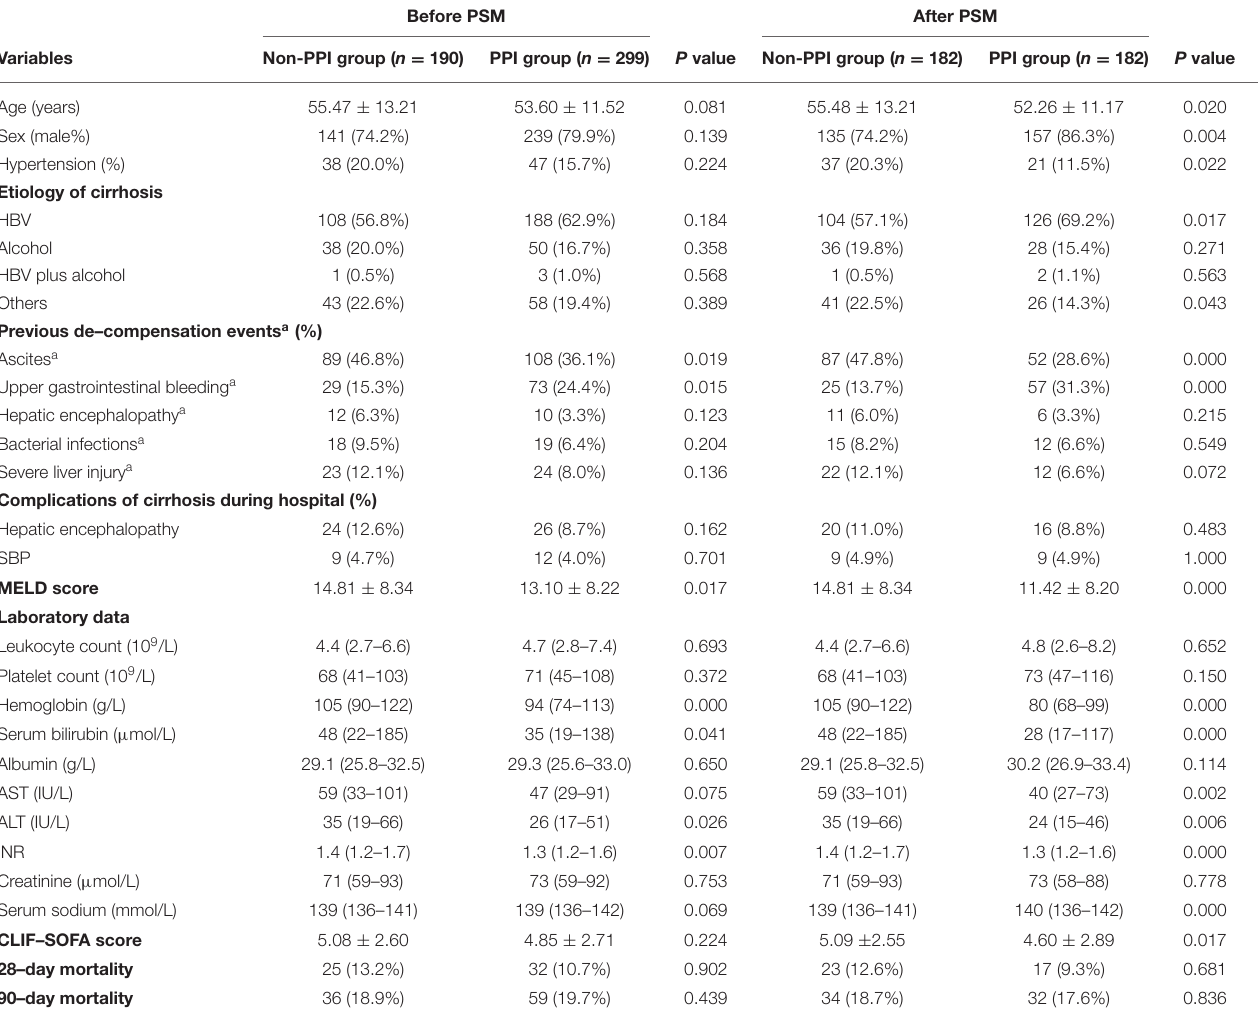
TABLE 1 | Baseline characteristics of the enrolled patients receiving and not receiving proton pump inhibitor (PPI)